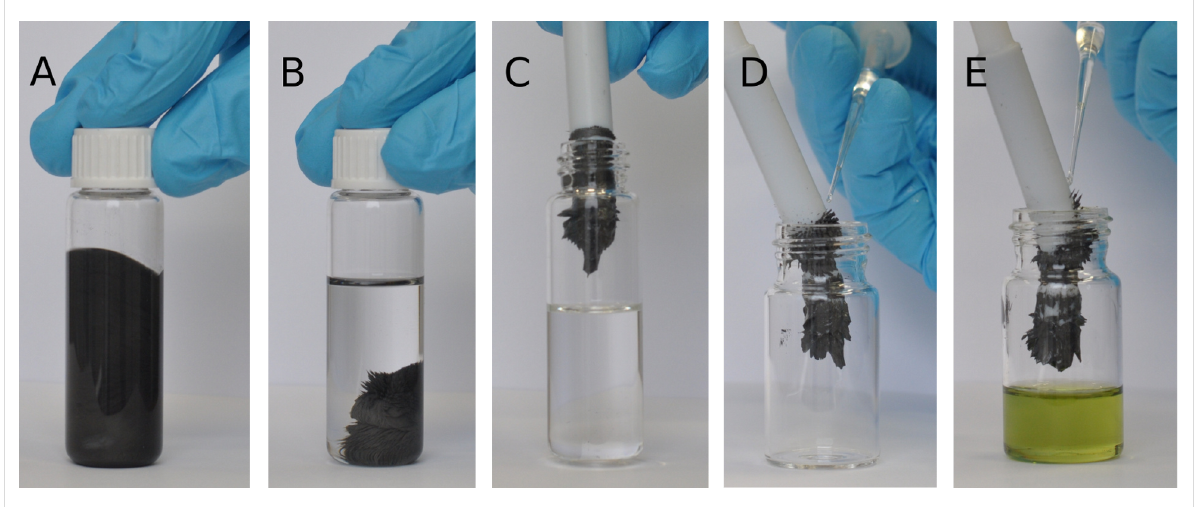
Figure 9: Removal of 8 -Fe and subsequent recovery of 8 . A: stirred reaction mixture containing 8-Fe , B: the same reaction mixture after stirring ceased, C: catalysts 8 -Fe attached to the magnetic rod and removed, D: catalyst 8 -Fe being washed with CH 2 Cl 2 , E: CH 2 Cl 2 solution of catalyst 8 removed from Fe powder.